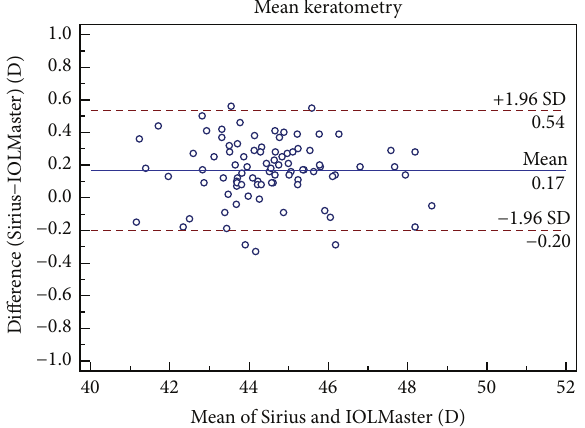
Figure 6: Bland-Altman plots of agreement of white to white readings taken with the Sirius Scheimpflug/Placido photography- based topography system and IOLMaster partial coherence inter- ferometry. The solid line indicates the mean difference (bias). The upper and lower lines represent the 95% limits of